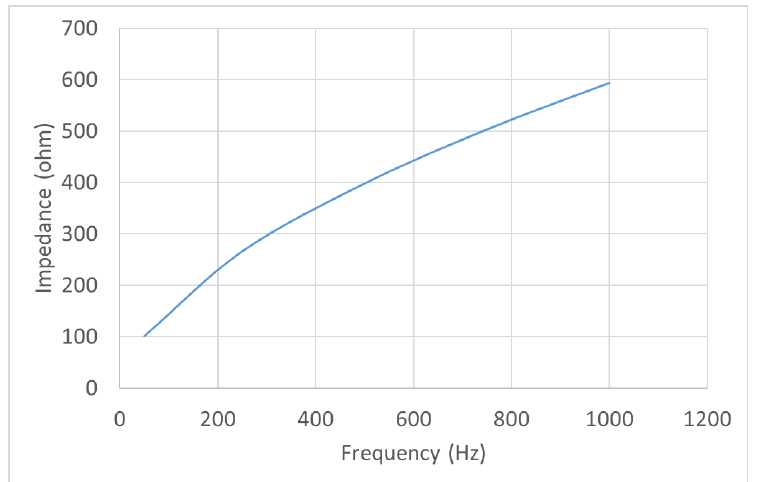
Figure 8. Impedance vs. frequency for the micromanipulator levitation system from ANSYS Maxwell.